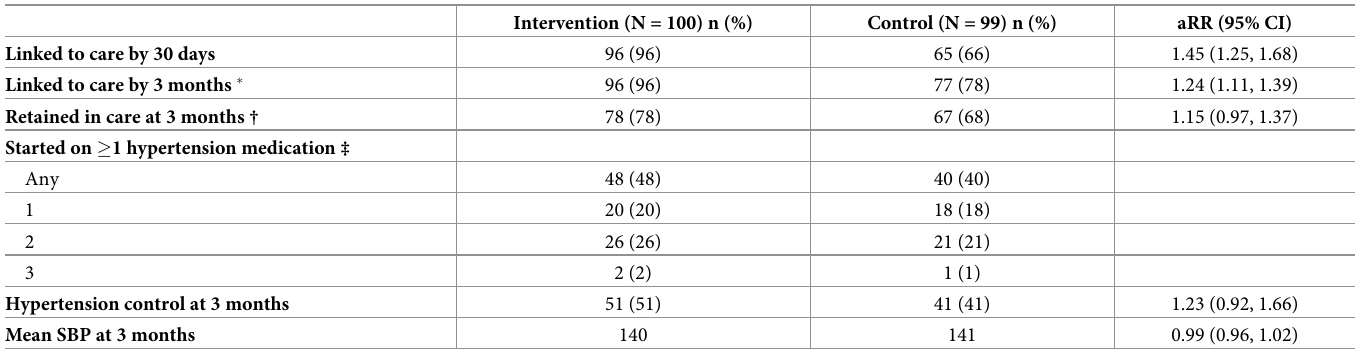
Table 2. Main study outcomes.